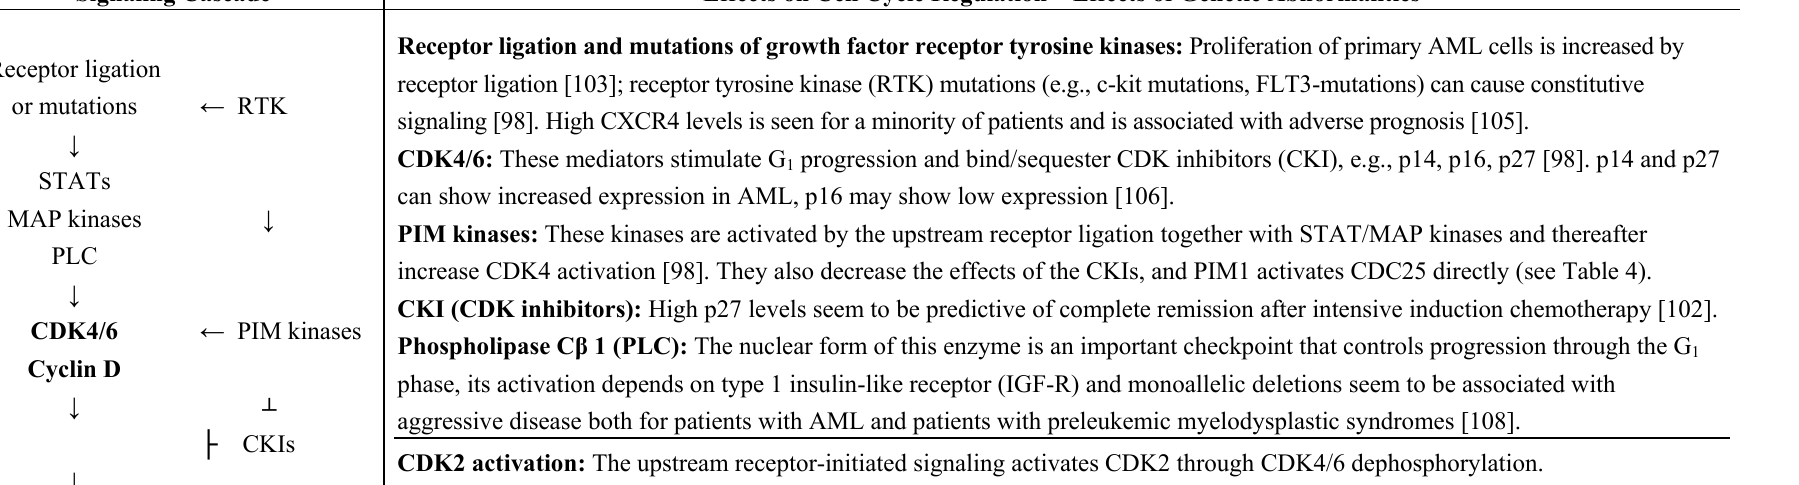
Table 2. The molecular environment of CDC25—altered regulation of the G 1 phase in human AML ( ← stimulation; ┴ inhibition). Signaling